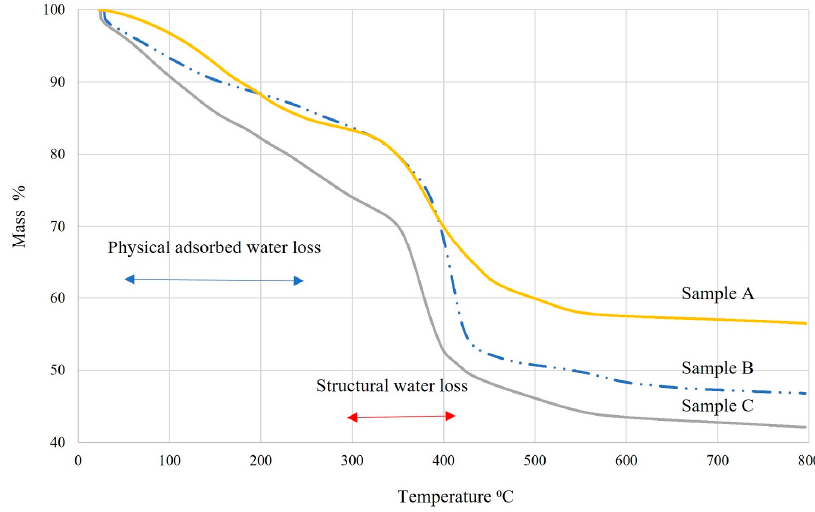
Figure 8. Thermogravimetric pattern of cementitious binder.